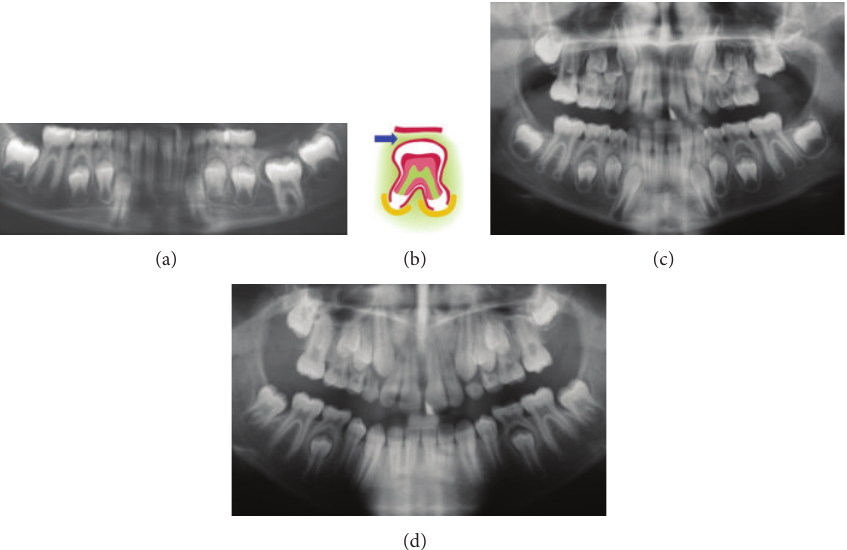
Figure 9: Drawing and radiograph showing a primarily retained permanent first molar. The cause is the crown follicle’s lack of ability to destroy the overlying osseous tissue (blue arrow on the drawing). The upper radiograph shows primary retention of the left mandibular first molar from a 10-year-old boy. The bottom two panoramic radiographs from the same girl, aged 8 years and 8 months (left) and 10 years and 8 months (right). The two radiographs show that surgical exposure of the left maxillary first molar after the left radiograph was taken results in eruption of the tooth (right). At the same time, the radiographs show that the second maxillary molar in the field where the primarily retained tooth was located is delayed in formation. The condition in the left maxillary molar field has thus affected both eruption and formation of the teeth. The condition may be connected with a virus infection during the first years of the patient’s life.